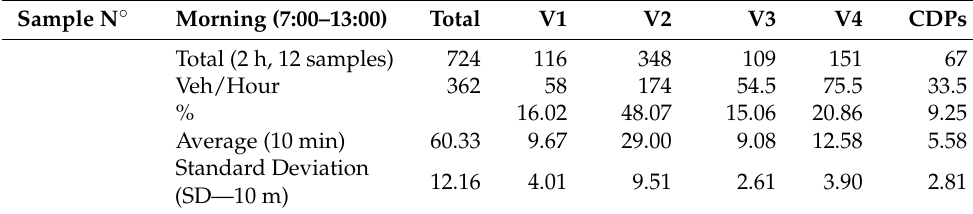
Table 1. Morning sample resume on business